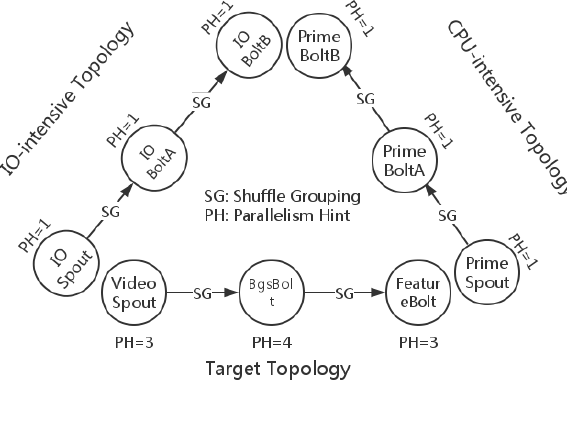
Figure 9. Topologies for